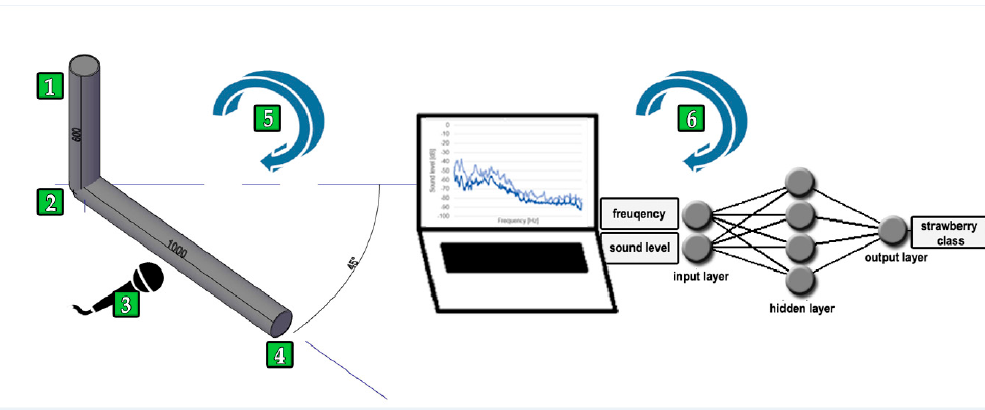
Figure 2. Samples of three acoustic spectra showing the level of sound intensity for dried strawberry fruits representing the ripe and over-ripe classes, with the following methods: ( a ) splash batch of five fruits, ( b ) splash batch of one fruit (the fruit lands in a glass filled with water), ( c ) squash batch with one fruit.